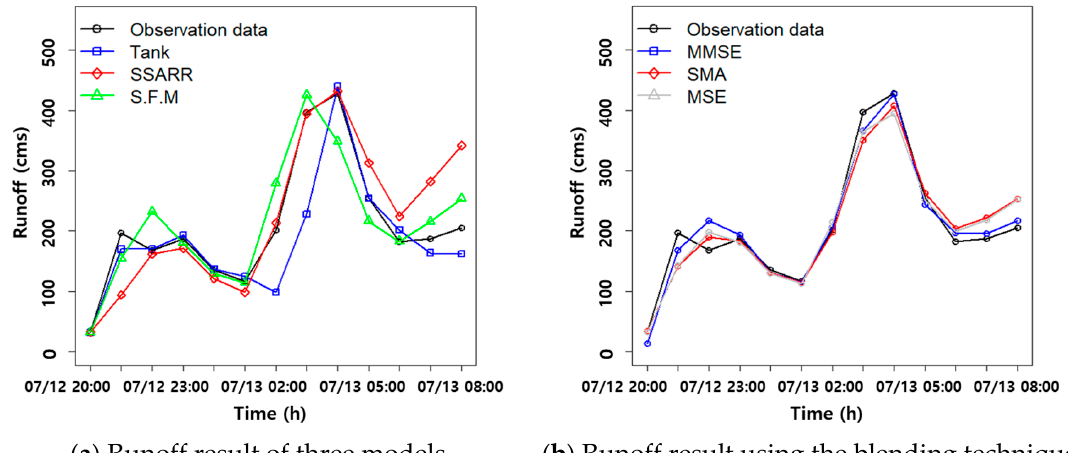
Figure 11. Runoff hydrograph using the observation data.